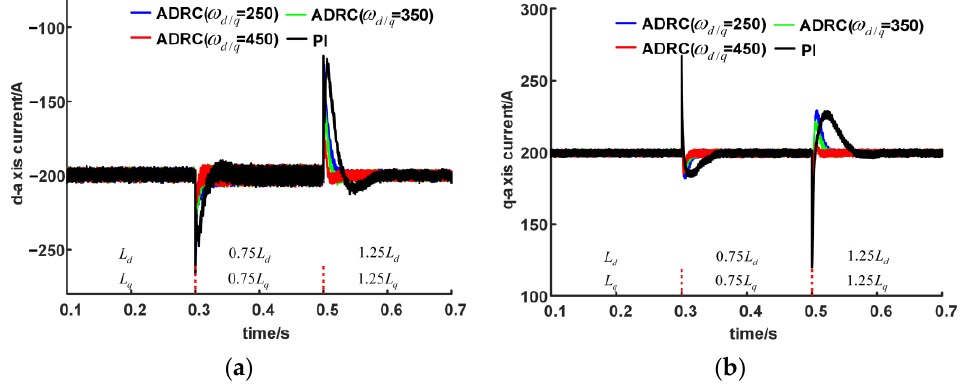
Figure 4. Dq-axis current waveforms: ( a ) d-axis current; ( b ) q-axis current.